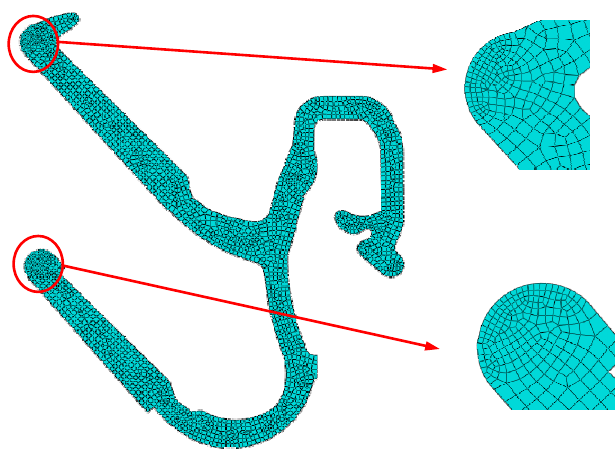
Figure 28. Inner belt mesh generation.